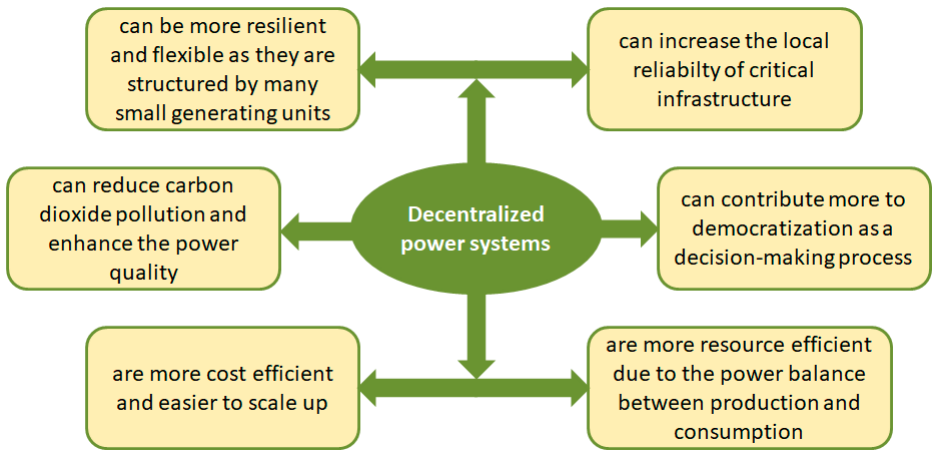
Figure 1. Advantages of decentralized power systems.